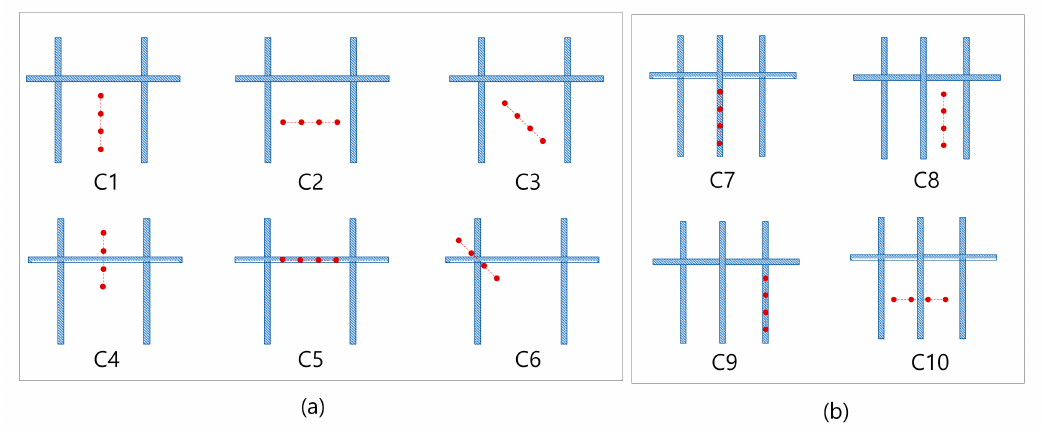
Figure 6. Wenner probe configuration: ( a , b ) for large and small delamination defects in concrete slab specimen